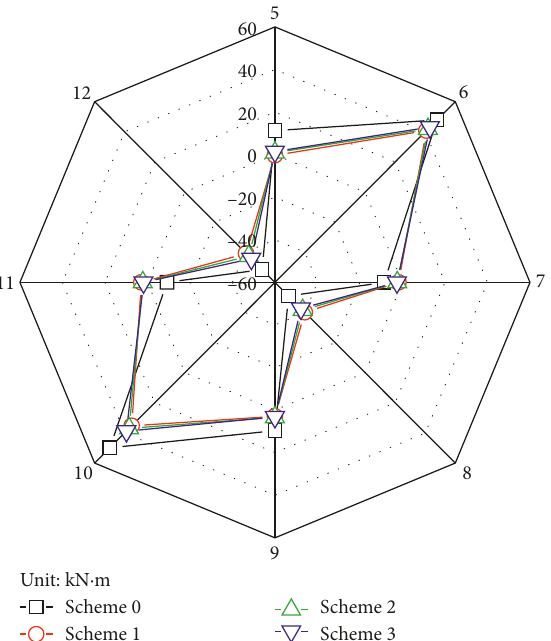
Figure 22: Additional bending moments of the tunnel structure after the building